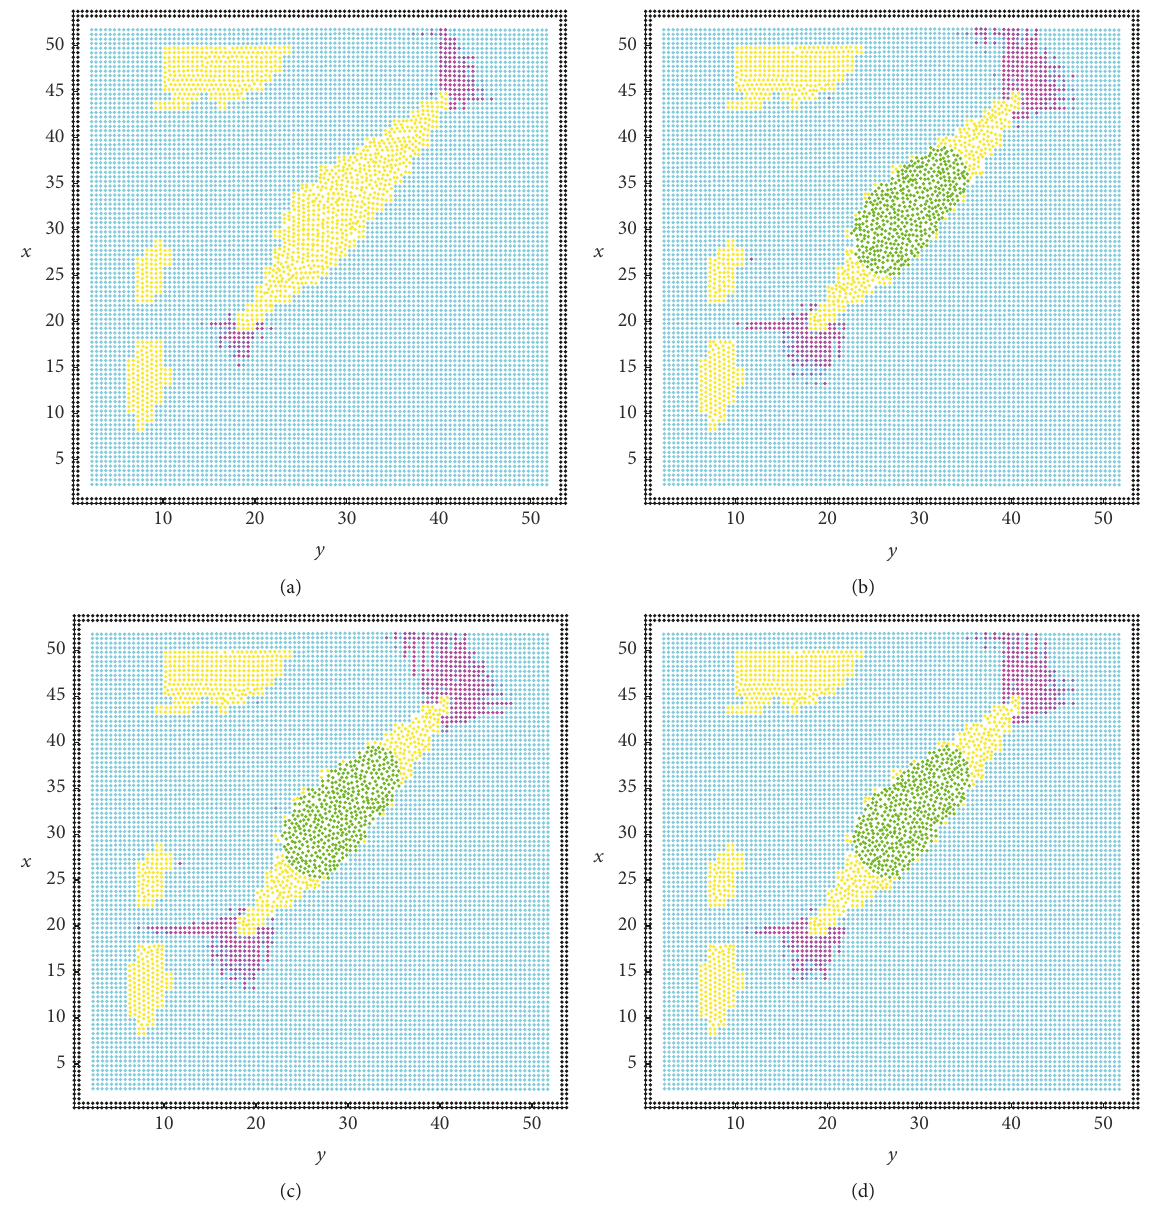
∼ 8 MPa. Green points conf